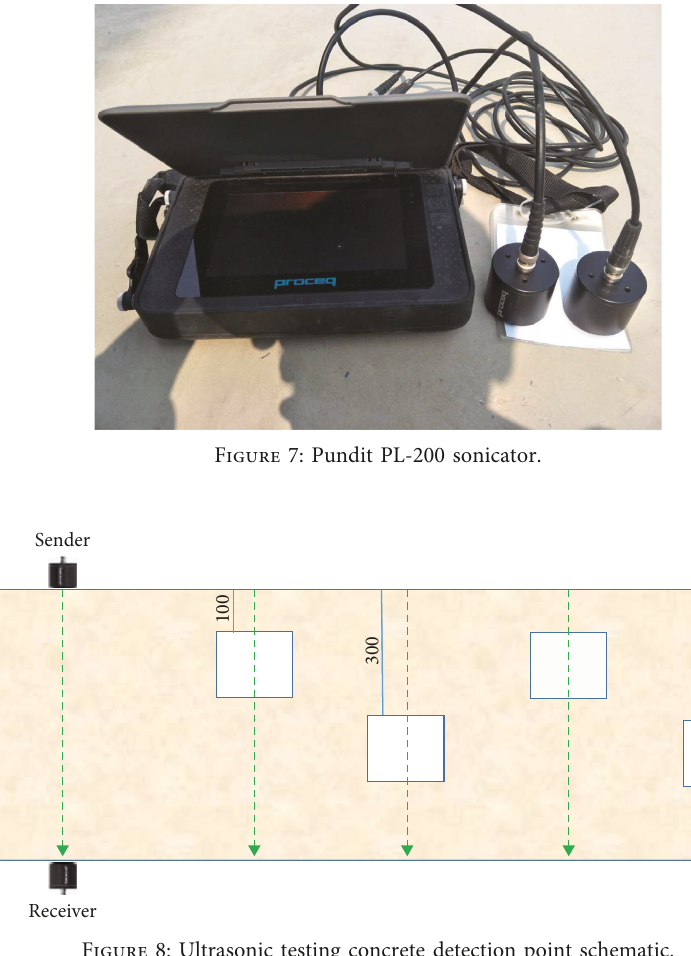
Figure 8: Ultrasonic testing concrete detection point schematic.